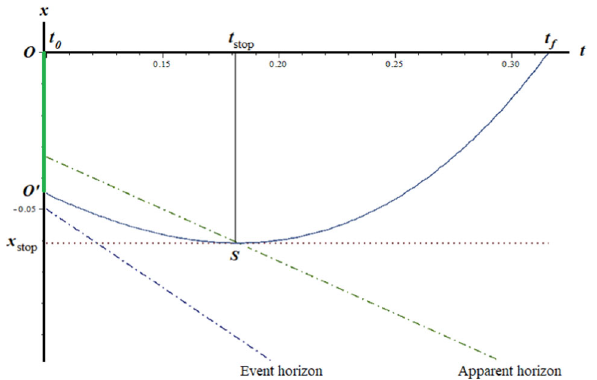
Fig. 5 Propagation of the wave packet with γ = 0 . 001 and ¯ k = 10000 in the space-time with s = 3, r a ( t 0 ) = 0 . 0333 and r e ( t 0 ) = 0 . 05. The packet is prepared in O (cid:4) at the time t 0 = 0 . 1 and r a ( t 0 ) < d = 0 . 045 < r e ( t 0 ) and measured in O at the time t f = 0 . 3162. We plot eight con- secutiveprofilesofthemaximumintensity I ( t , x ) (inlogarithmicscale) between t 0 and t f at equal time intervals, Δ t = 0 . 0308. The maximum intensity stops in x stop = − 0 . 0608 at the time t stop = 0 .